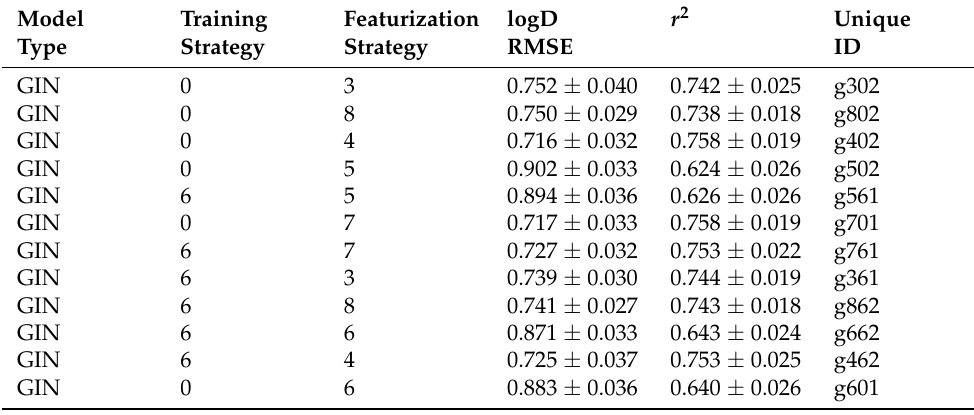
Table A18. Shows the logP RMSE and r 2 results for the GIN model type used during this survey. The last column consists of the unique identifier. Training strategy 0 represents a training strategy combining logD, logS, and logP, 1 represents a strategy combining logD and logP, 2 stands for a combination of logD and logS, 3 represents a strategy using logS and logP, 4 represents a strategy using logD, 5 represents a strategy using logS, and 6 represents a strategy using